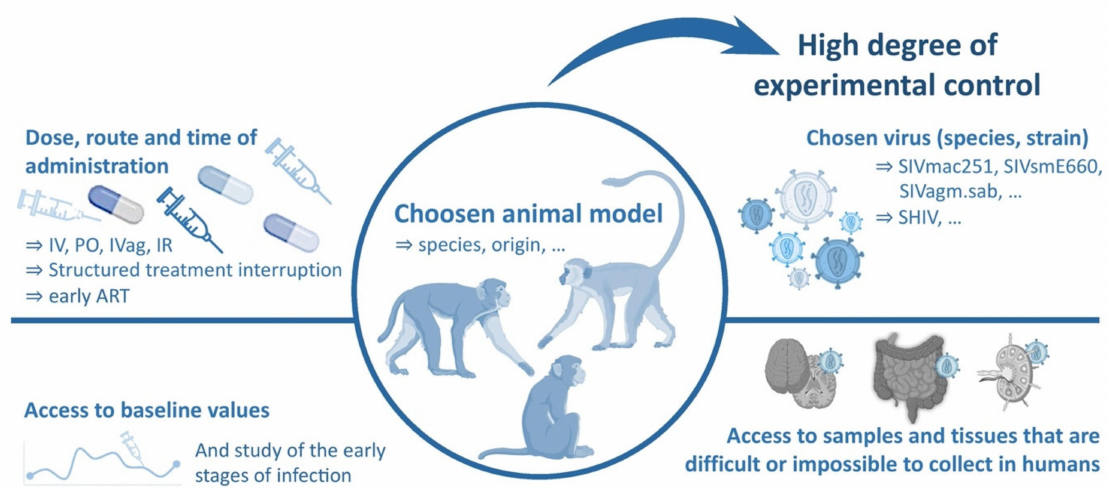
Figure 1. Interests and prerogatives of Non-Human Primates (NHP) models for HIV science. NHP models can be designed according to the question addressed, choosing primates from different species or origins that can be infected with different viruses. NHP models provide a means to study samples and tissues that are challenging to obtain and study in humans, as well as the possibility to access baseline values of the studied parameters and to study the earliest stages of infection after inoculation. Distinct times and routes of administration can be tested and analytical treatment interruptions (ATI) can be easily performed and